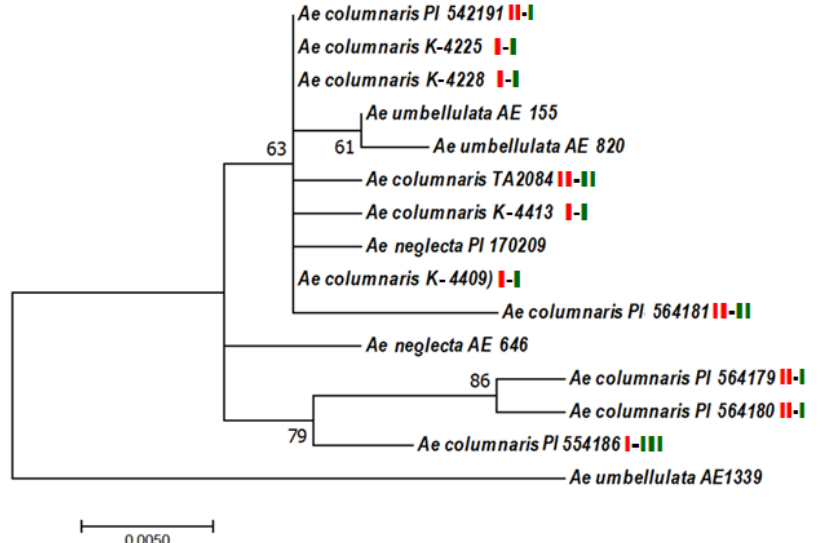
Figure 11. Maximum-likelihood (Kimura 2-parameter model) tree of the U-genome-specific U31 nuclear sequence. The numbers above the branches indicate bootstrap values; the C-banding group is shown in red, U31 allele type –in green.